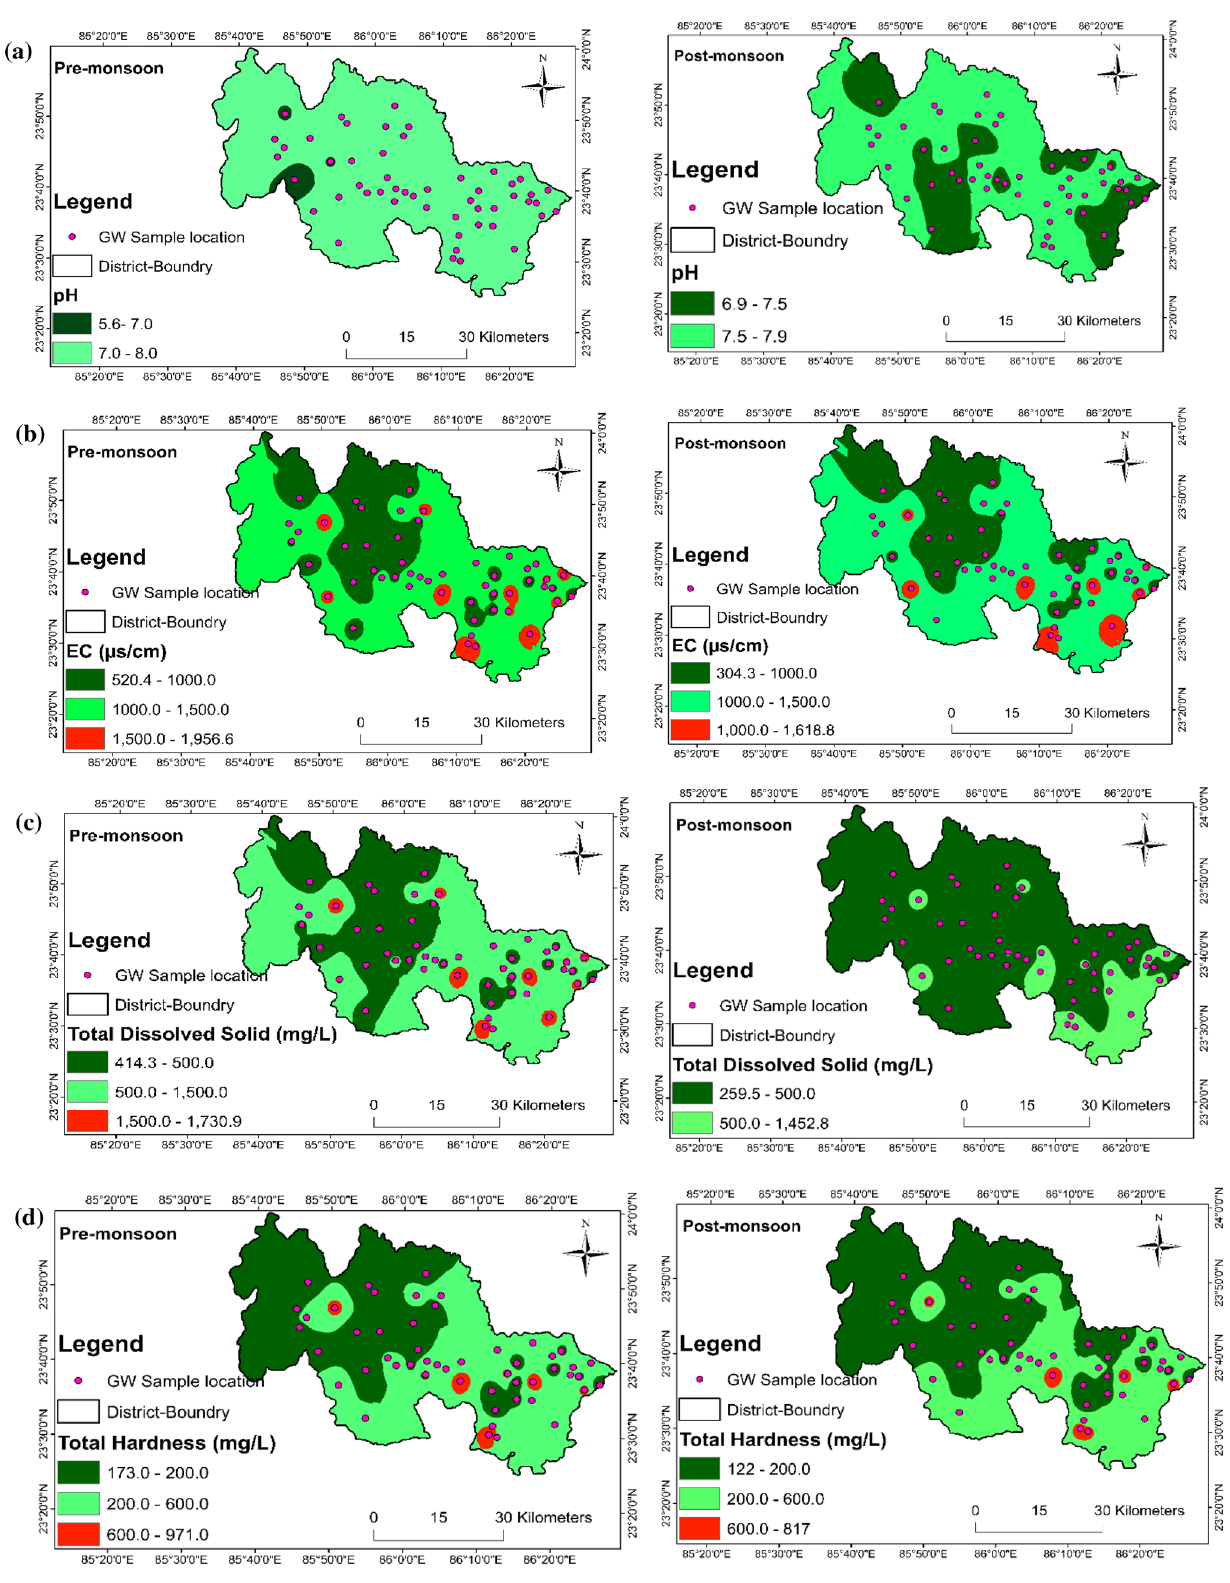
Fig. 3 Spatial variations in pH, EC, TDS and